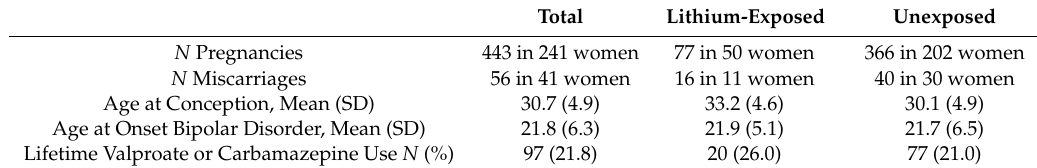
Table 1. Characteristics of study